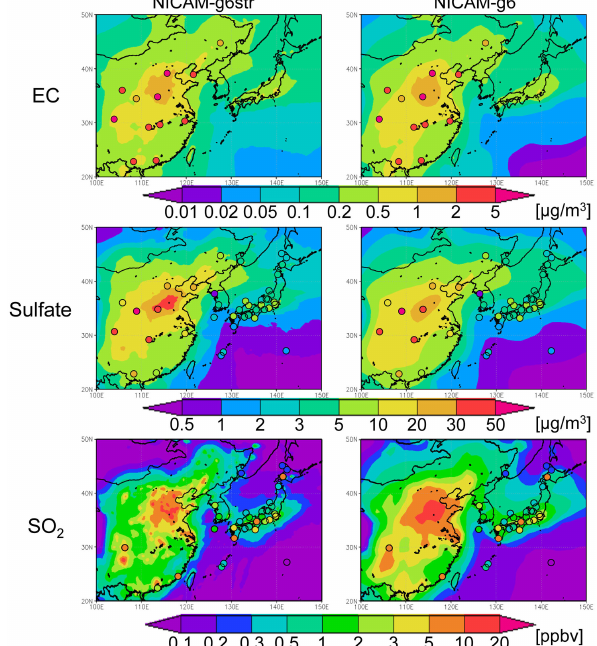
Figure 15. Horizontal distributions of concentrations for EC, sulfate and SO 2 near the surface using NICAM-g6str and NICAM-g6 in August averages. The circles in color show the observation results at the sites.